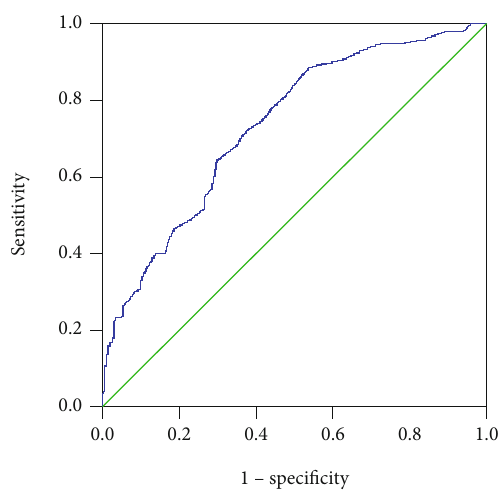
Figure 4: Receiver operating characteristic curve analysis of stimulated C-peptide cut point for HbA1c ≤ 7 : 0 % . Area under curve = 0 : 733 ( P < 0 : 001 ), 95% con fi dence interval: 0.673 – 0.793; identified cystatinC cut point = 0 : 615ng/mL ; sensitivity: 72.63%; speci fi city: